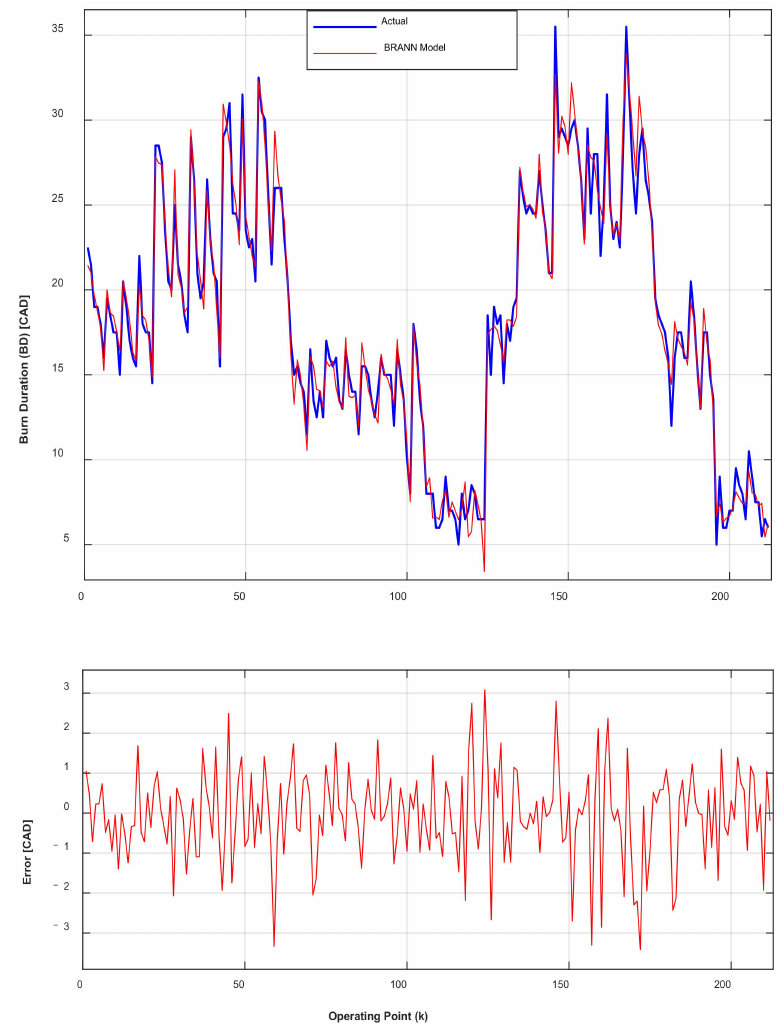
Figure 16. Comparison of the BRANN BD model and the actual